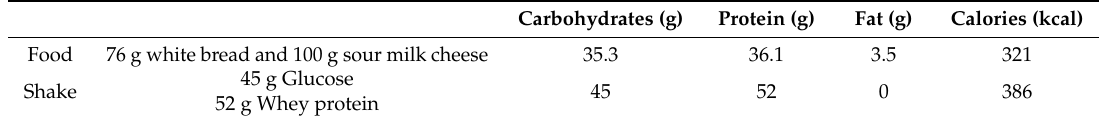
Table 2. Compositions and calories of protein/carbohydrate